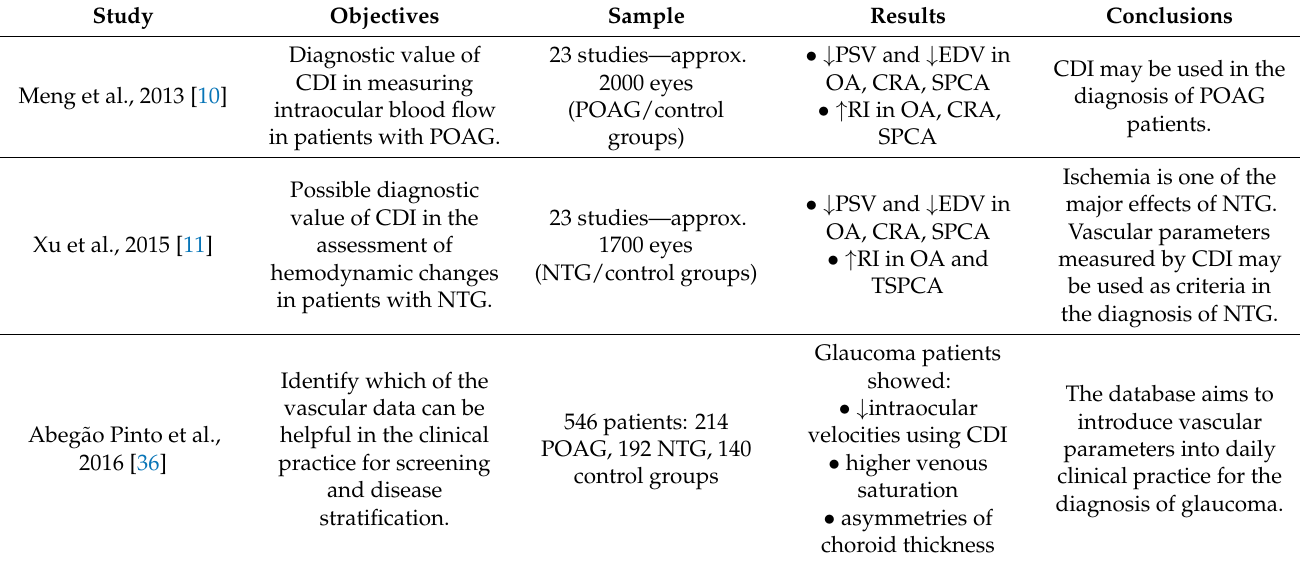
Table 2. Studies comparing Glaucoma versus Control